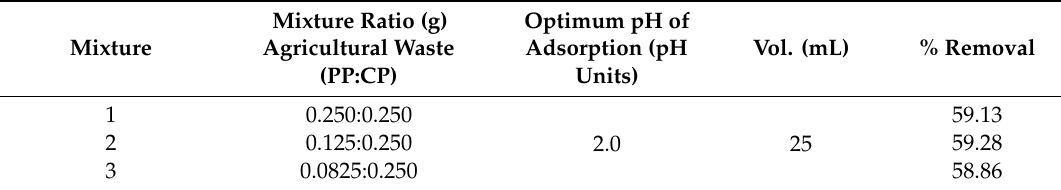
Table 4. Results of the mixtures in different proportions between the CP and PP for the removal of Cr (VI).